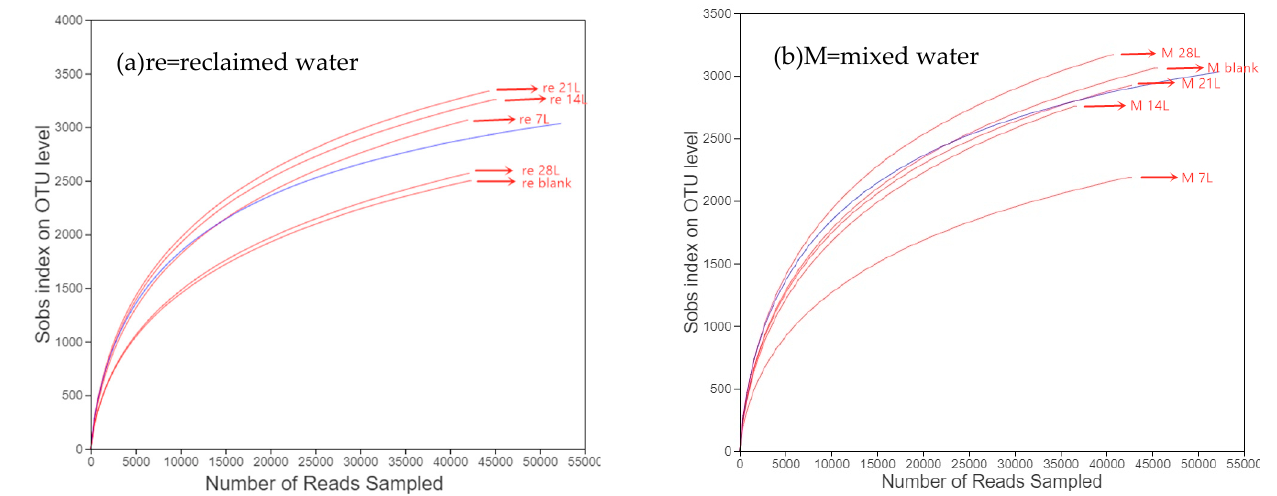
Figure 5. Dilution curves for soil communities in the reclaimed ( a ) and mixed water ( b ). with different exchange flow rates (the blue curve represents the soil before tests).